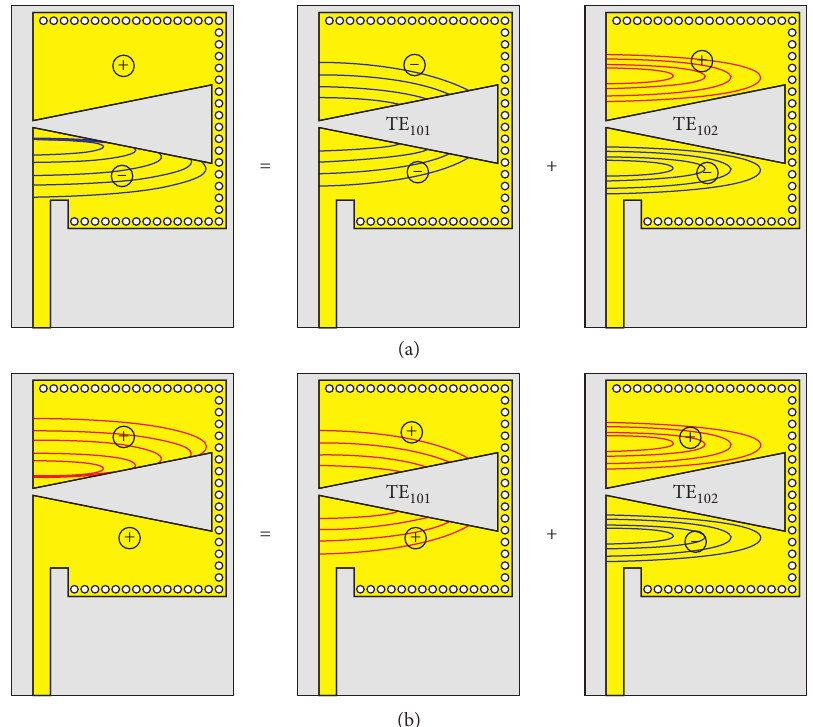
Figure 6: Combination of the simulated dominant E-field between the first mode TE